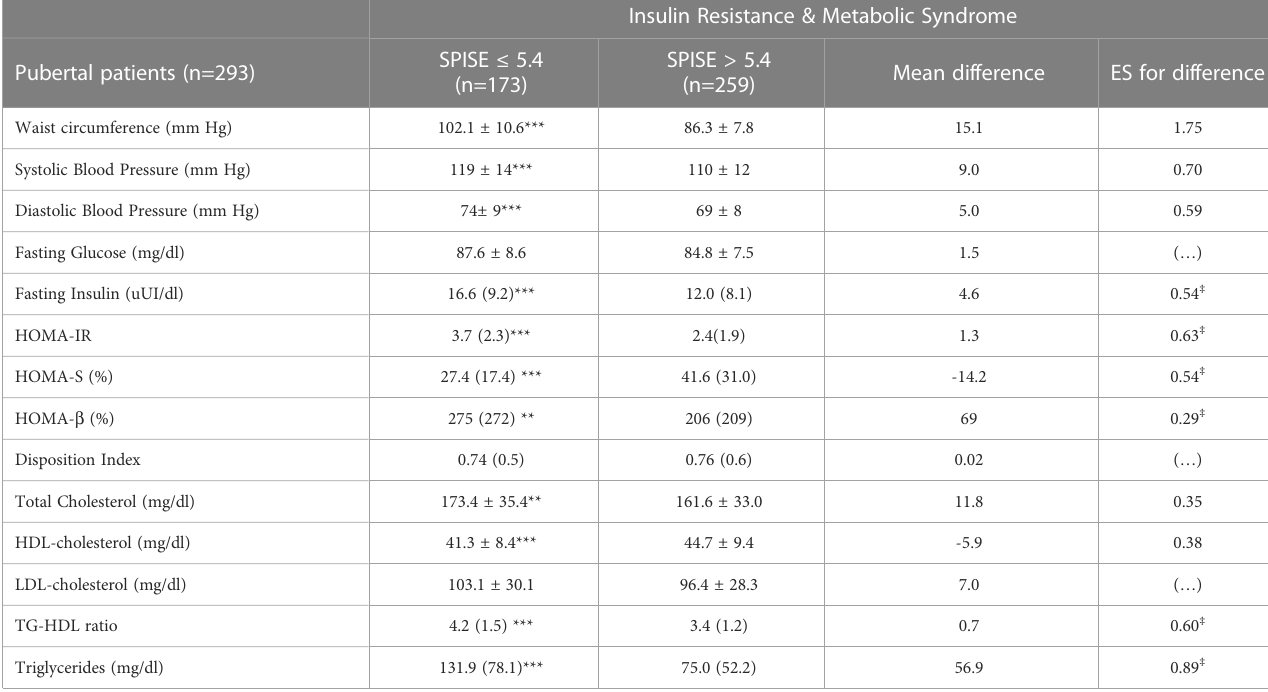
TABLE 5 Cardiometabolic pro fi le in pubertal obese patients according to optimal cutoff values of SPISE to predict IR (5.4) and MetS